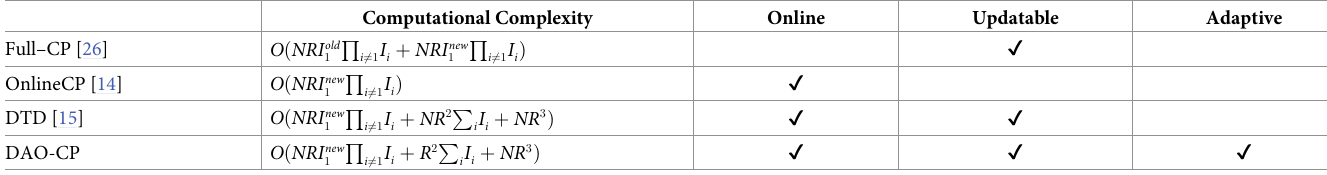
Table 3. Comparison of existing tensor decomposition methods (Full–CP refers to the static CP decomposition method). Computational Complexity Online Updatable